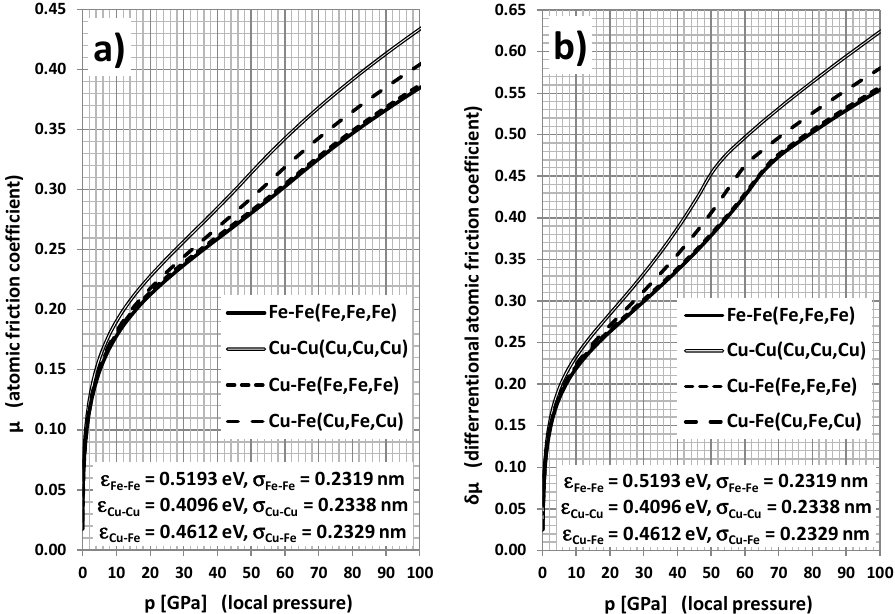
Figure 4. Regular ( a ) and differential ( b ) atomic friction coefficient dependence on local pressure for different atomic pairs: Fe-Fe(Fe,Fe,Fe), Cu-Cu(Cu,Cu,Cu), Cu-Fe(Fe,Fe,Fe), and Cu-Fe(Cu,Fe,Cu). Atoms specified in parentheses constitute a rigid environment of an “elastic” atom of the base.